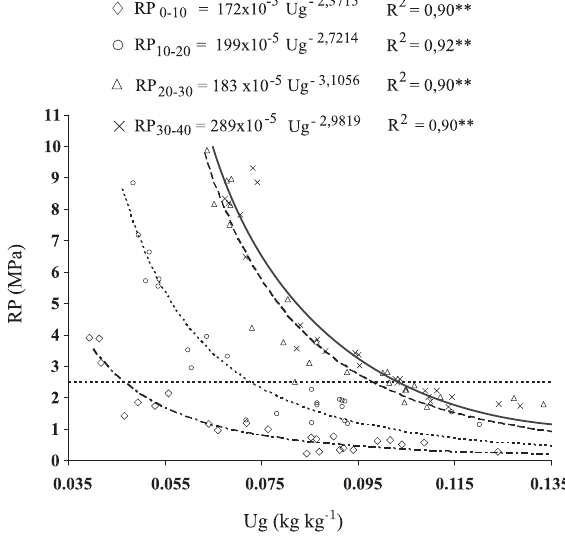
Figura 2. variação da resistência à penetração (RP) em função do conteúdo de água no solo (ug) nas diferentes camadas do solo estudado, em três datas de avaliação. o símbolo ** indica que os modelos ajustados foram significativos (F <